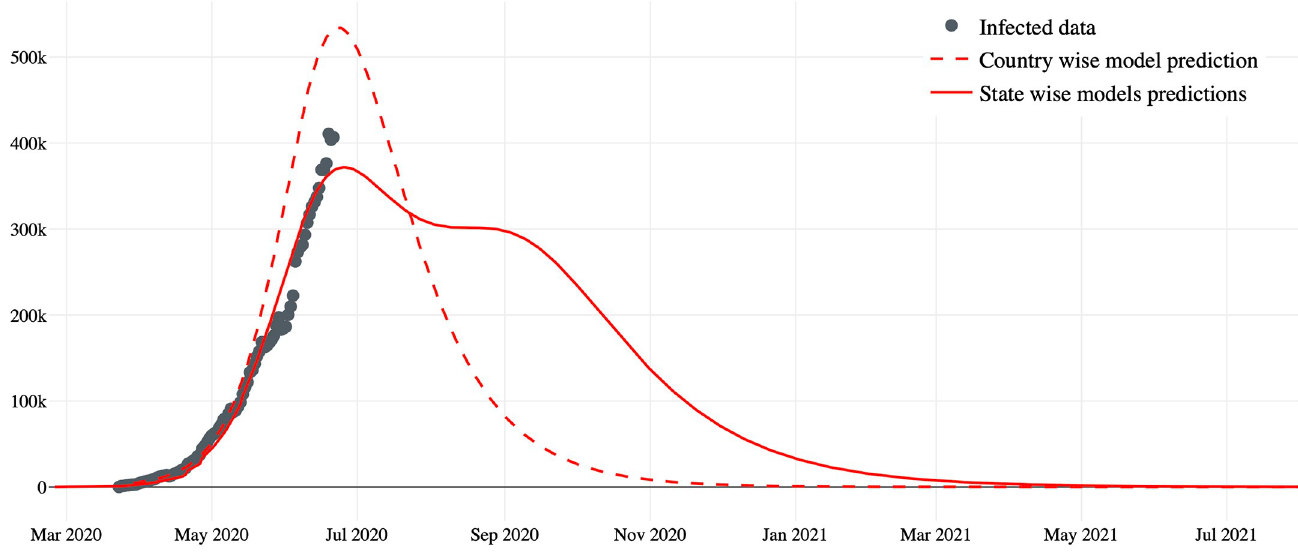
Fig 3. Comparison of predictions using the estimated models with real data for each state.